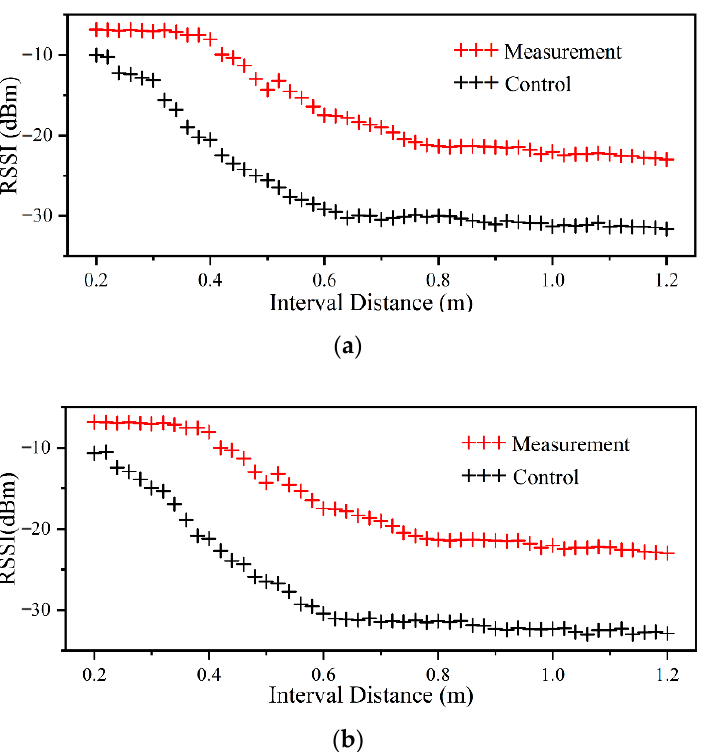
Figure 10. Laboratory RSSI values with samples containing different MC levels. ( a ) is a laboratory-